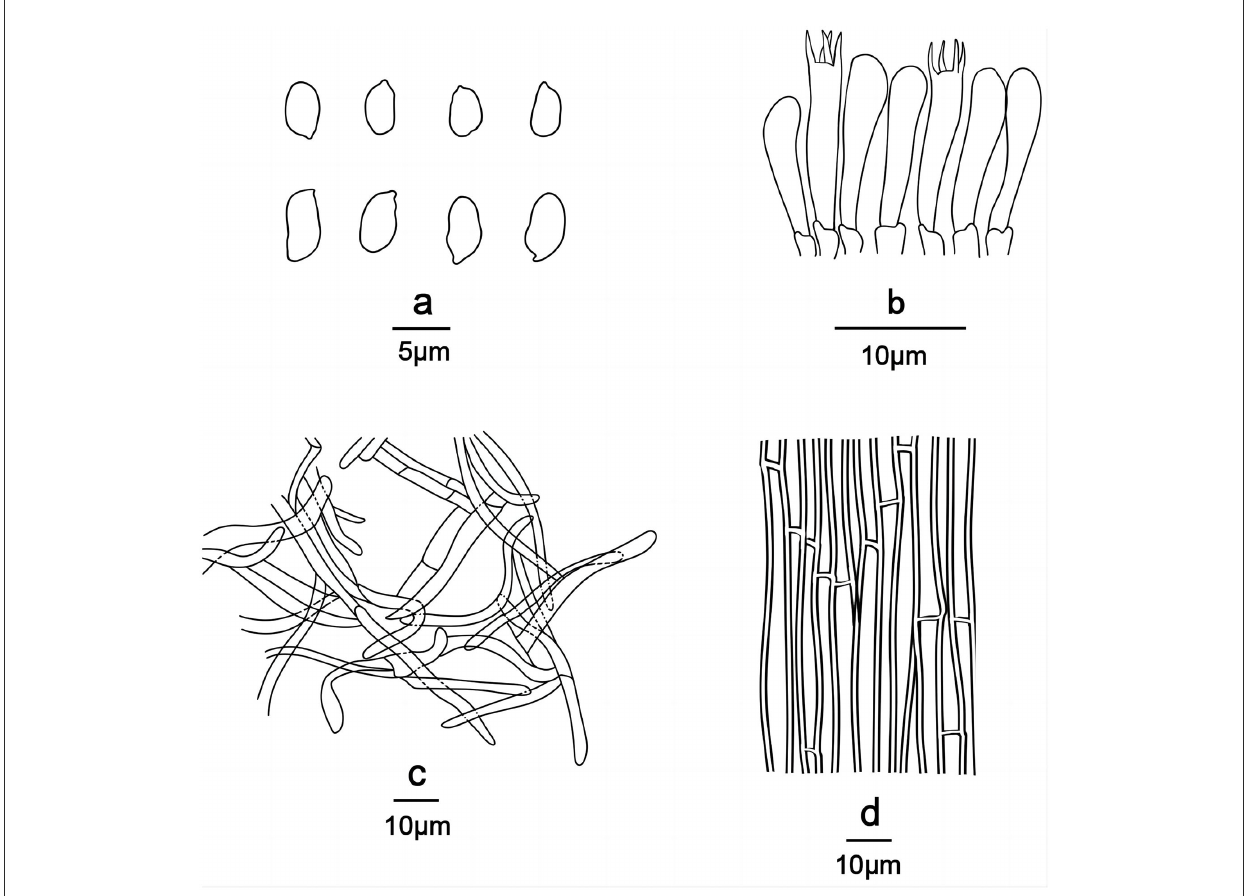
FIGURE5 Line drawings of Gerhardtia tomentosa (Holotype, SYAU-FUNGI-074). (a) Basidiospores, (b) basidia and basidioles, (c) Pileipellis, and (d) hyphae from trama.